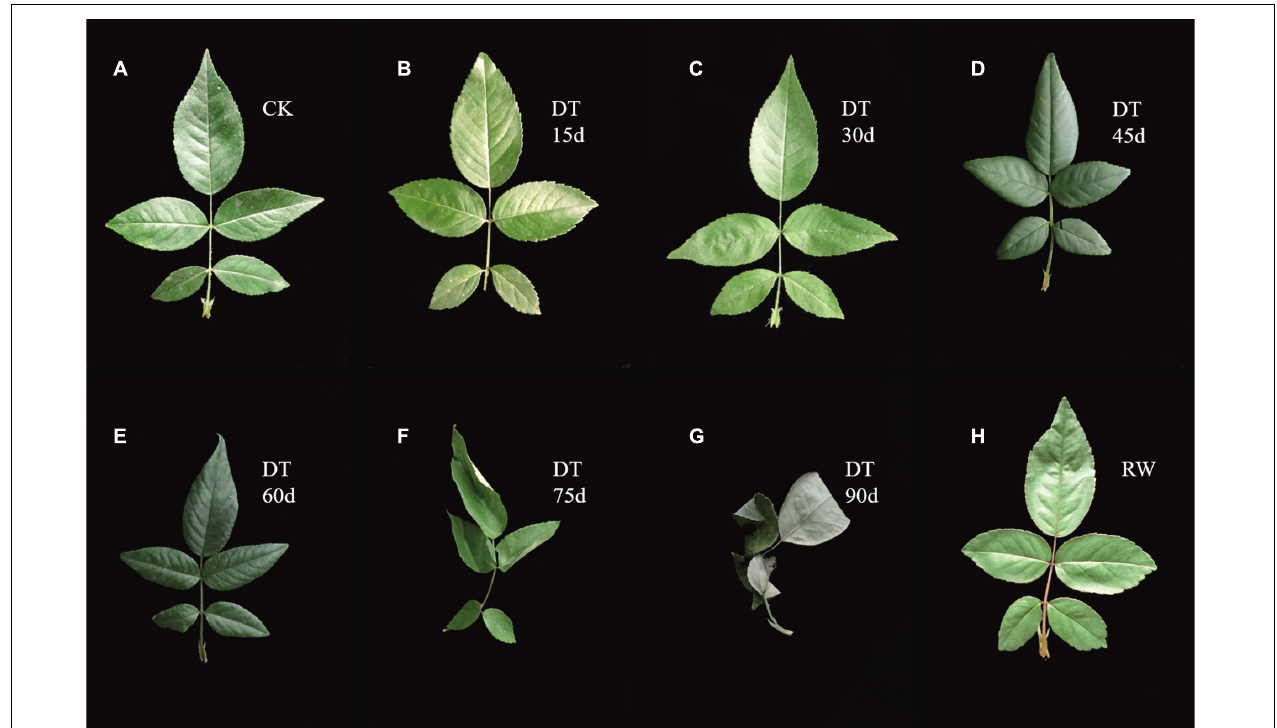
FIGURE 1 | Leaf phenotypes of Rosa chinensis ‘Old Blush’ leaves during drought and rewatering stages. (A) The control plants. (B) Drought treatment for 15 days. (C) Drought treatment for 30 days. (D) Drought treatment for 45 days. (E) Drought treatment for 60 days. (F) Drought treatment for 75 days. (G) Drought treatment for 90 days. (H) Rewatering